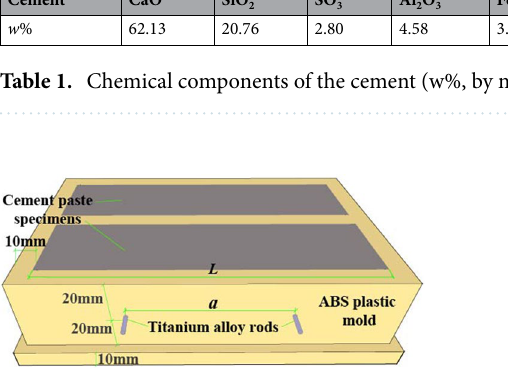
Figure 1. Schematic of sample with precast titanium alloy rod